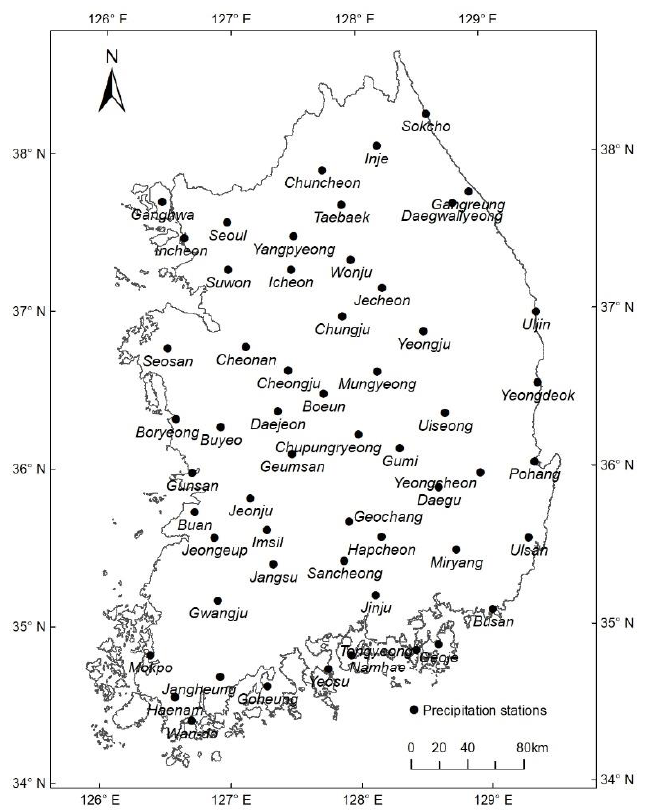
Figure 1. Location of 56 precipitation stations in South Korea.